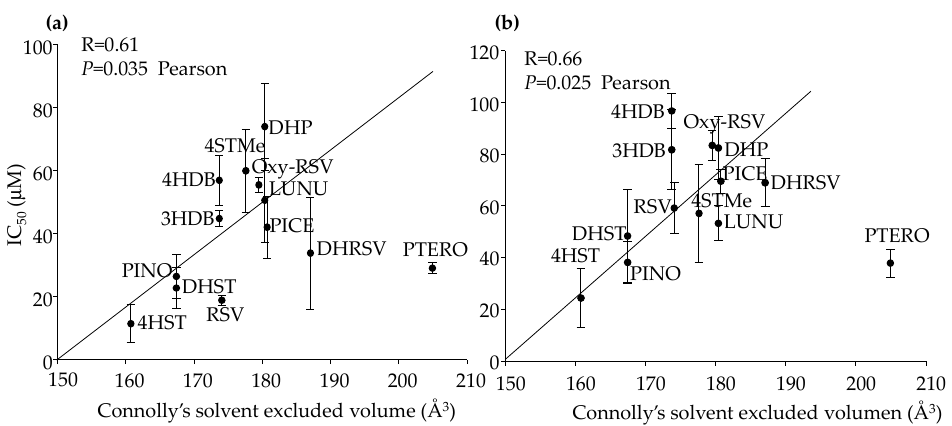
Figure 6. IC 50 dependence on Connolly’s solvent-excluded volume in Caco-2 ( a ) and HT-29 ( b ) cells. Pearson correlation values were calculated excluding PTERO. Values are shown as mean ± SD (n = 3).